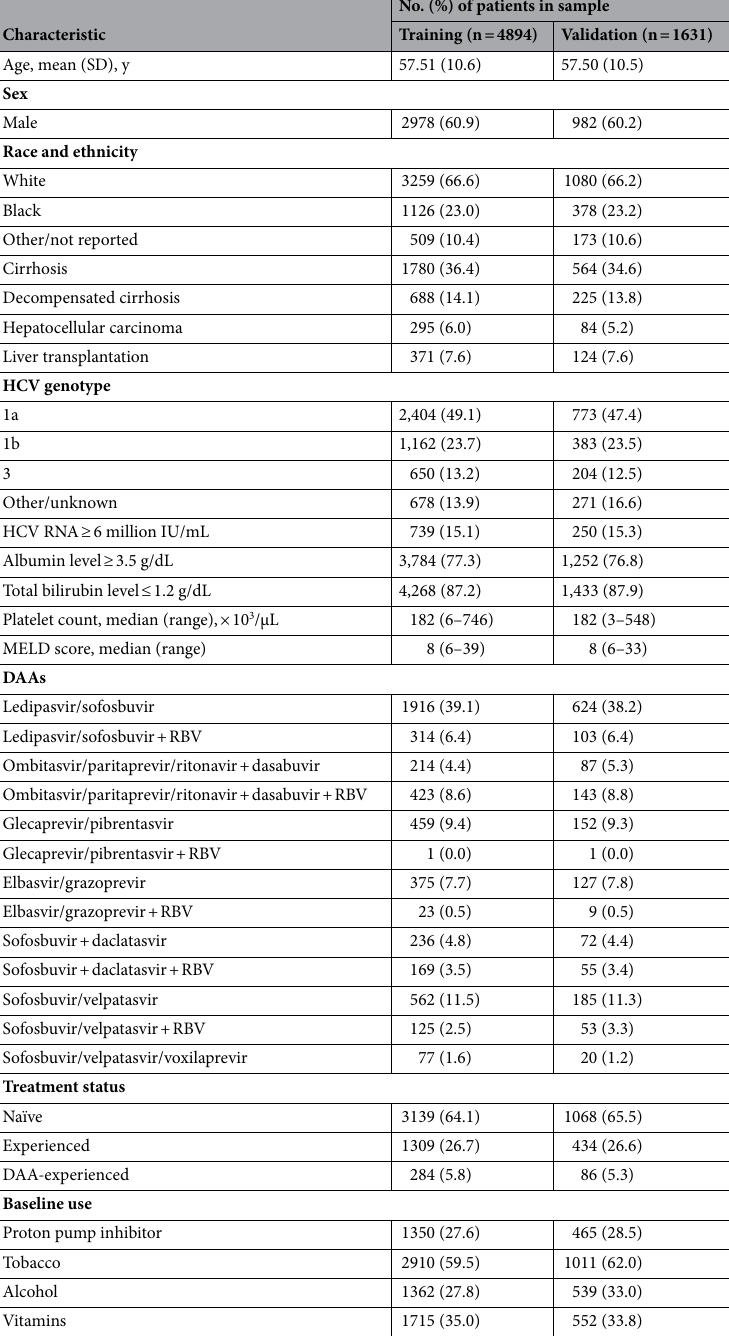
Table 1. Baseline sociodemographic and clinical characteristics of patients treated with all-oral DAAs and DAA treatment failure rates, stratified by training and validation samples. DAA direct-acting antiviral, HCV hepatitis C virus, MELD model for end-stage liver disease, RBV